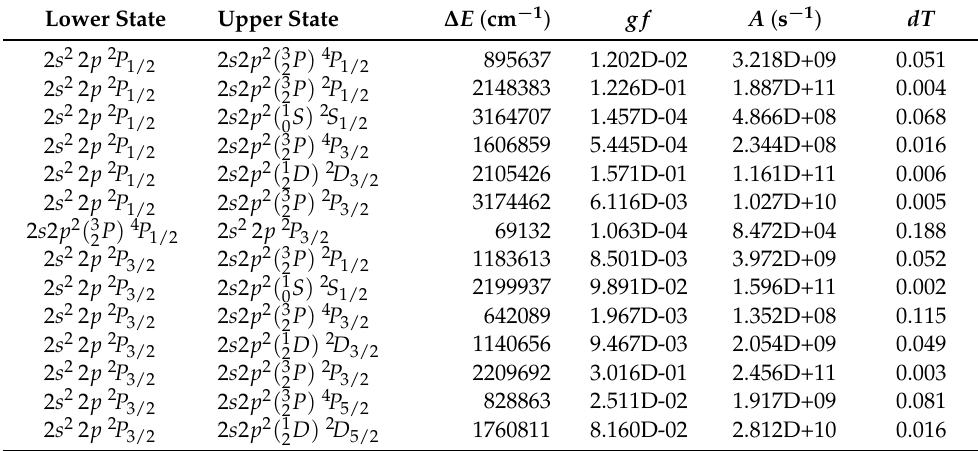
Table 11. Transition data from the file